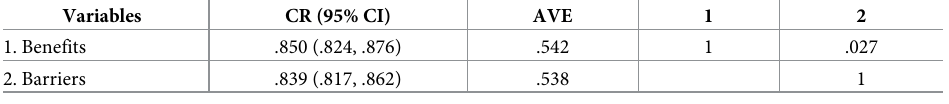
Table 2. Composite reliability [10], average variance extraction (AVE), factor correlation and squared correlation for DB-M final